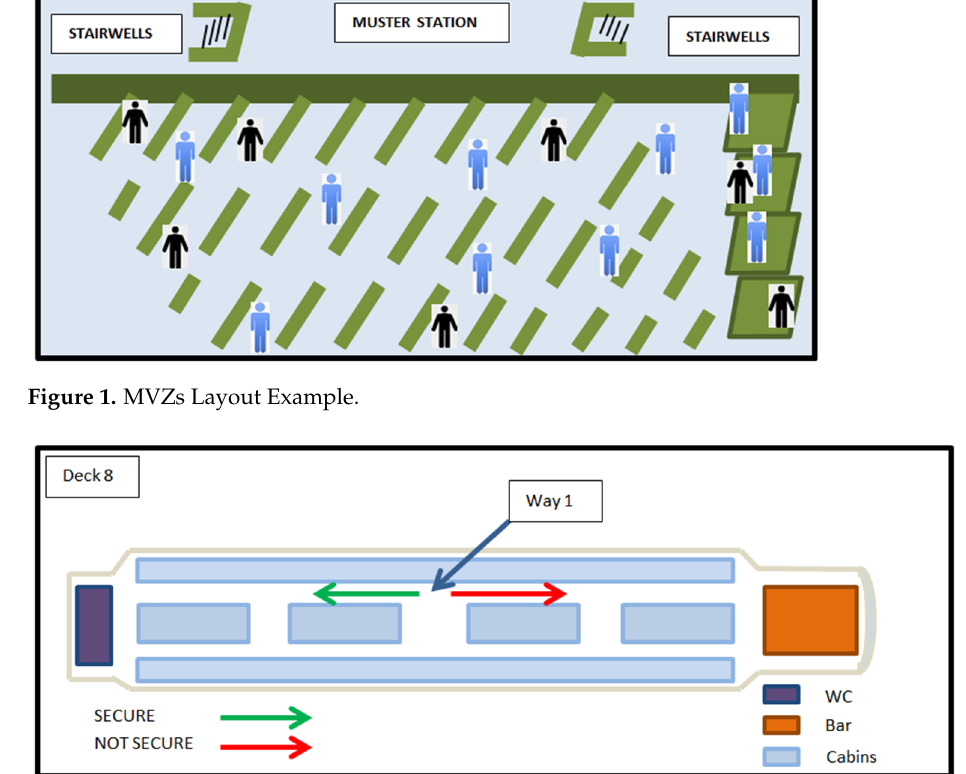
Figure 1. MVZs Layout Example .